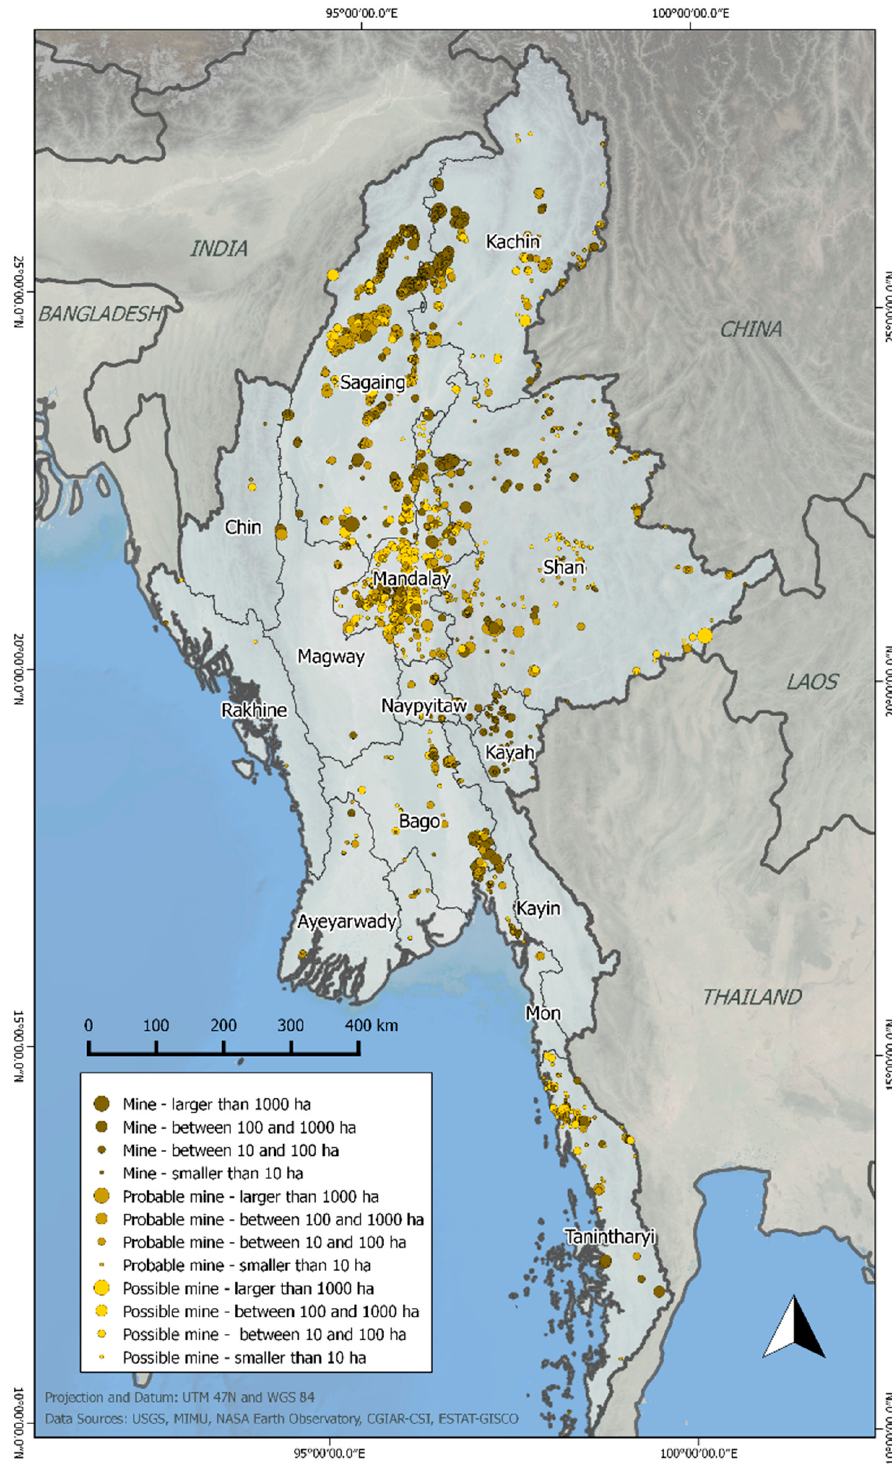
Figure 3. Locations of potential mining areas based on confidence of identification: High certainty (“Mine”), medium certainty (“Probable mine”) and low certainty (“Possible mine”).